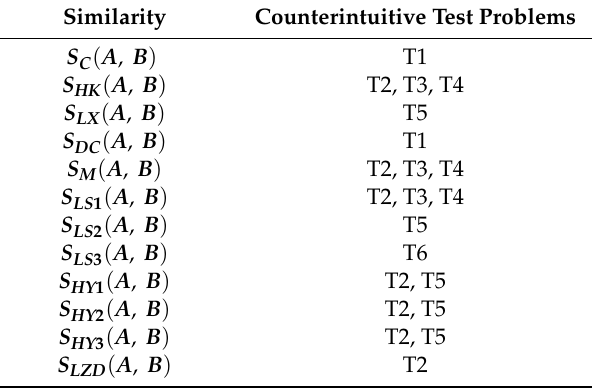
Table 3. The counterintuitive test problems of distance-based similarity